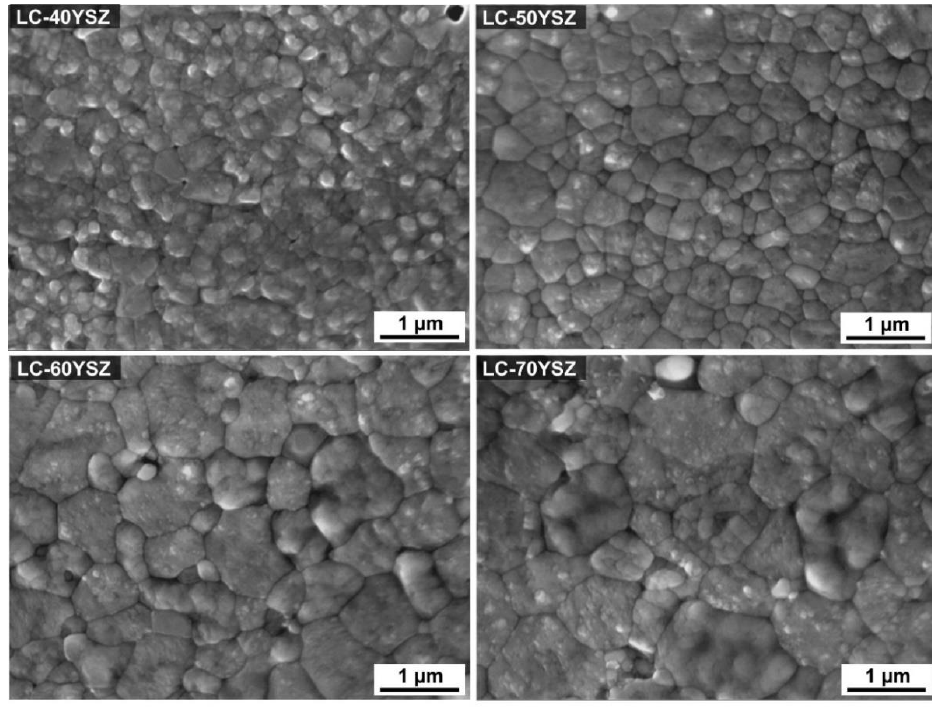
Figure 4. The SEM microstructures of hot-pressed LC-YSZ composites.